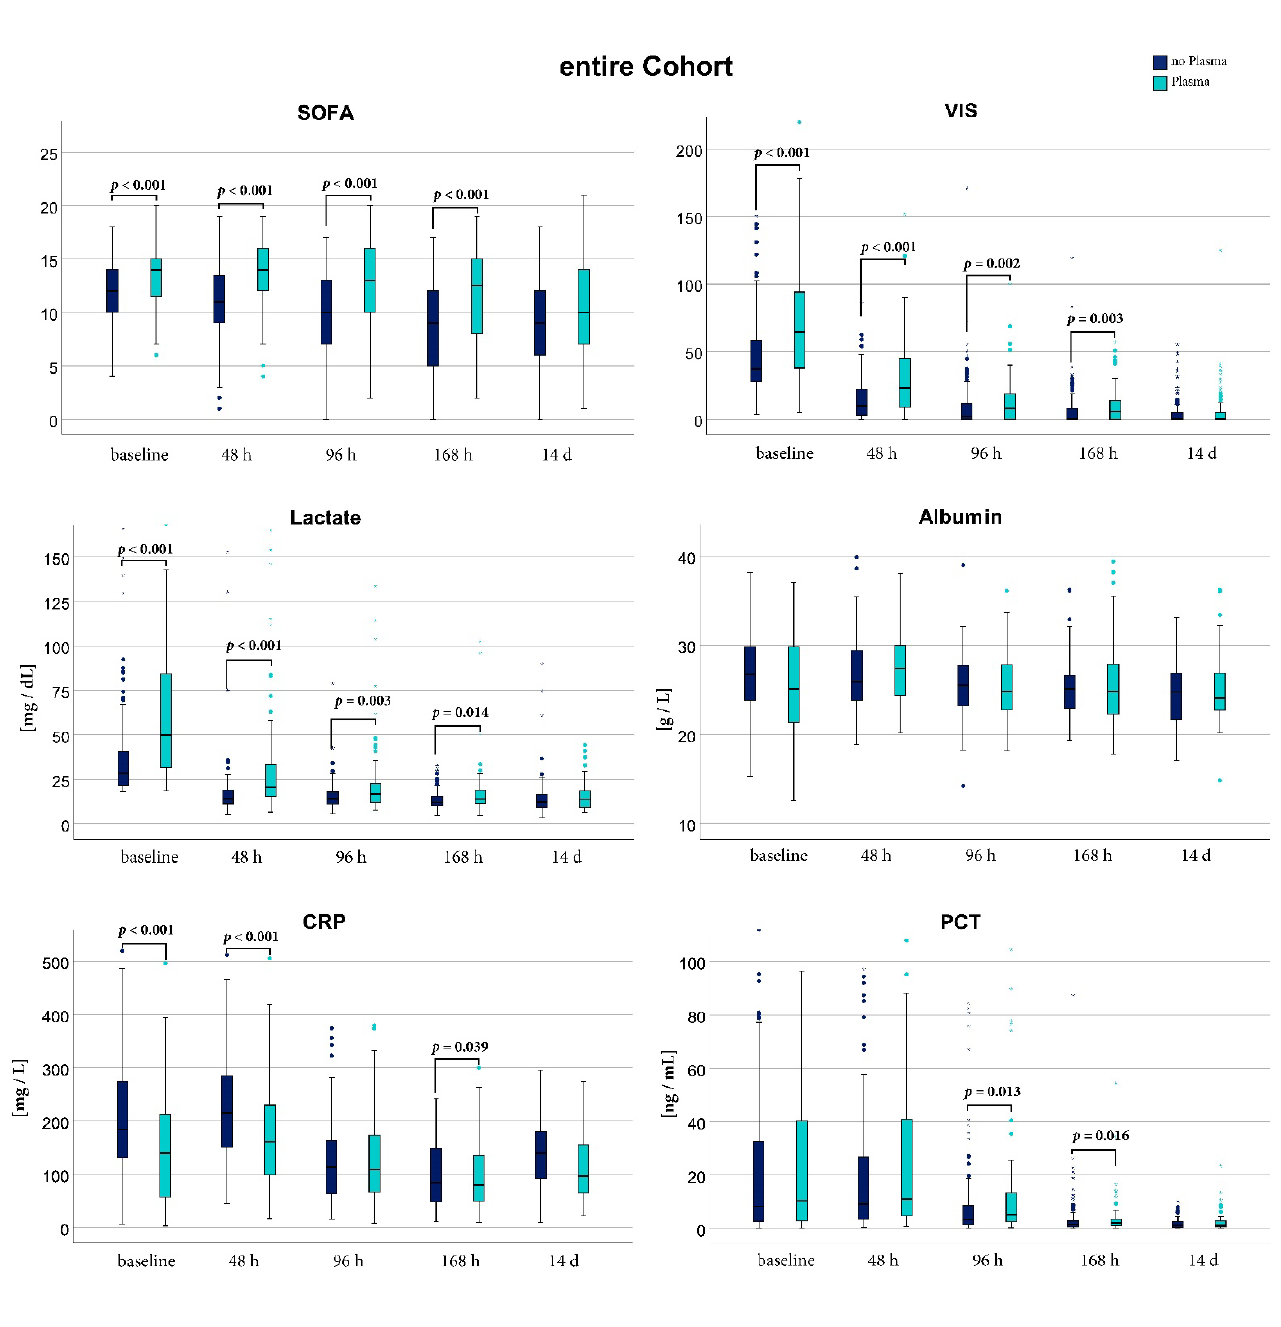
Figure 4. Septic shock related parameters at different points in time of the entire cohort. Comparison of the plasma group (cyan) and the control group (dark blue) was performed with a Mann Whitney U test. SOFA: Sepsis related Organ Failure Assessment Score; VIS: Vasoactive Inotropic Score; CRP: C-related Protein; PCT: Procalcitonin; [mg/dL]: milligram per deciliter; [g/L] gram per liter; [mg/L]: milligram per liter; [ng/mL]: nanogram per milliliter [h]: hours; [d]: days.